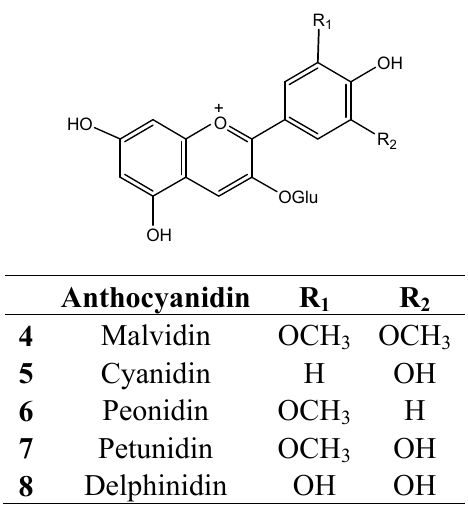
Figure 2. Structures of anthocyanins in